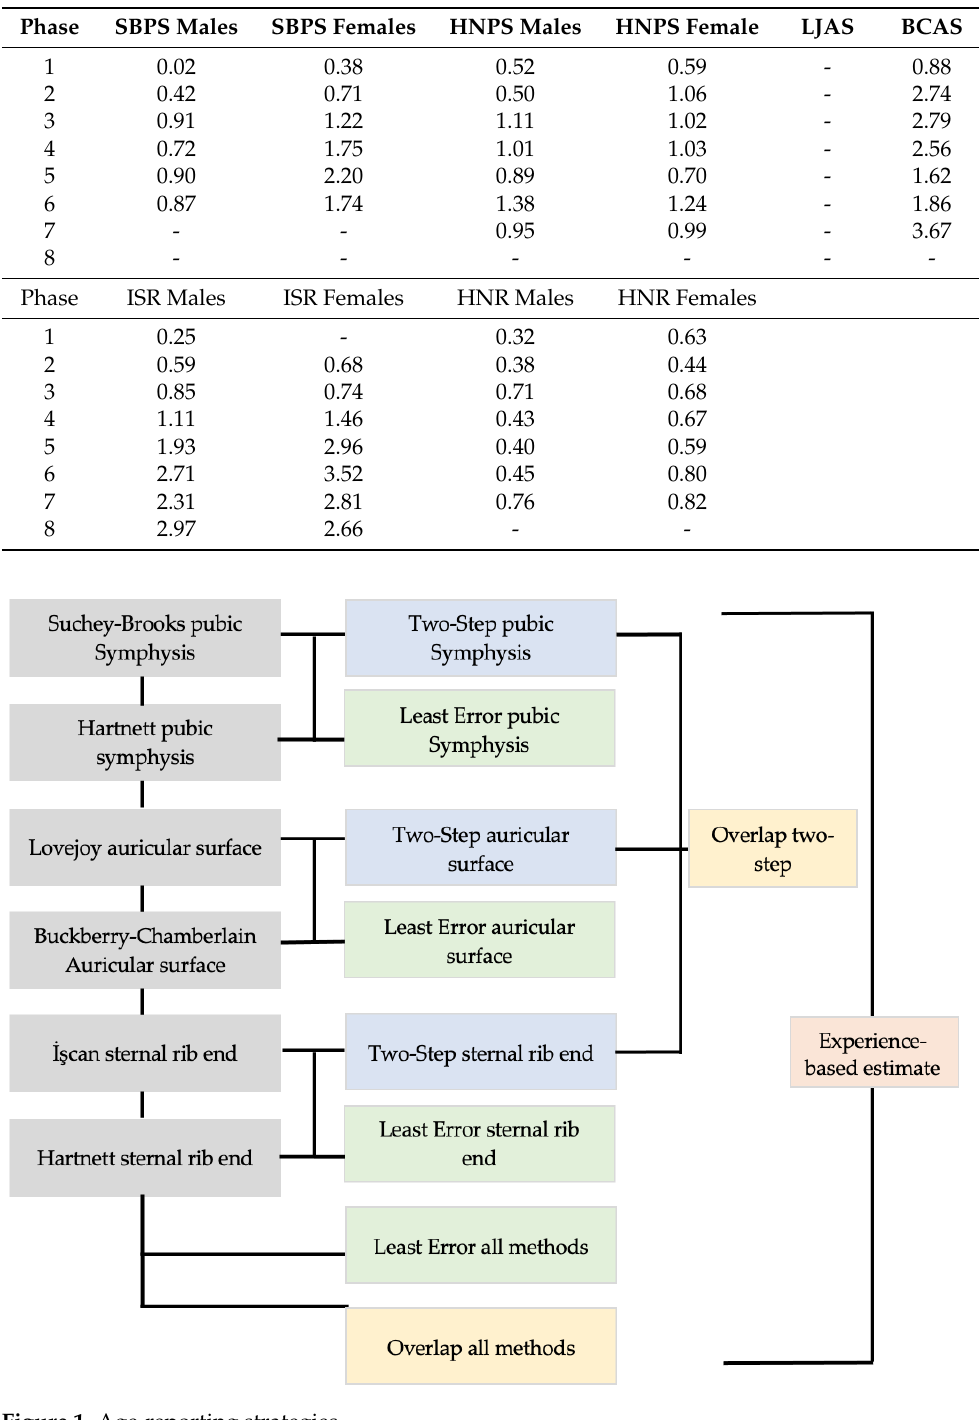
Table 3. Standard Error for Each Method.